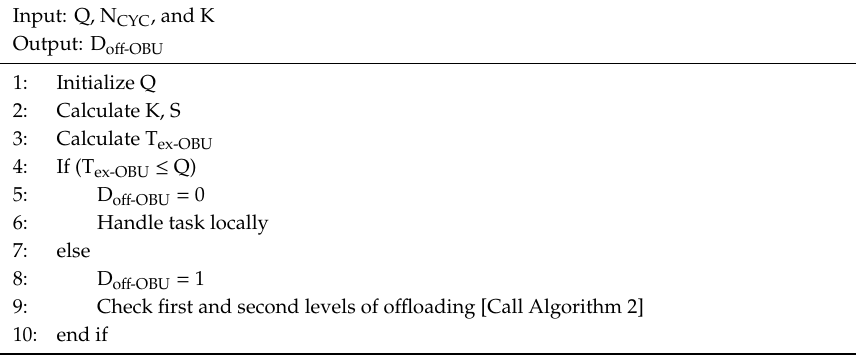
Algorithm 1. Latency-aware o ffl oading algorithm for multilevel based VANET system.